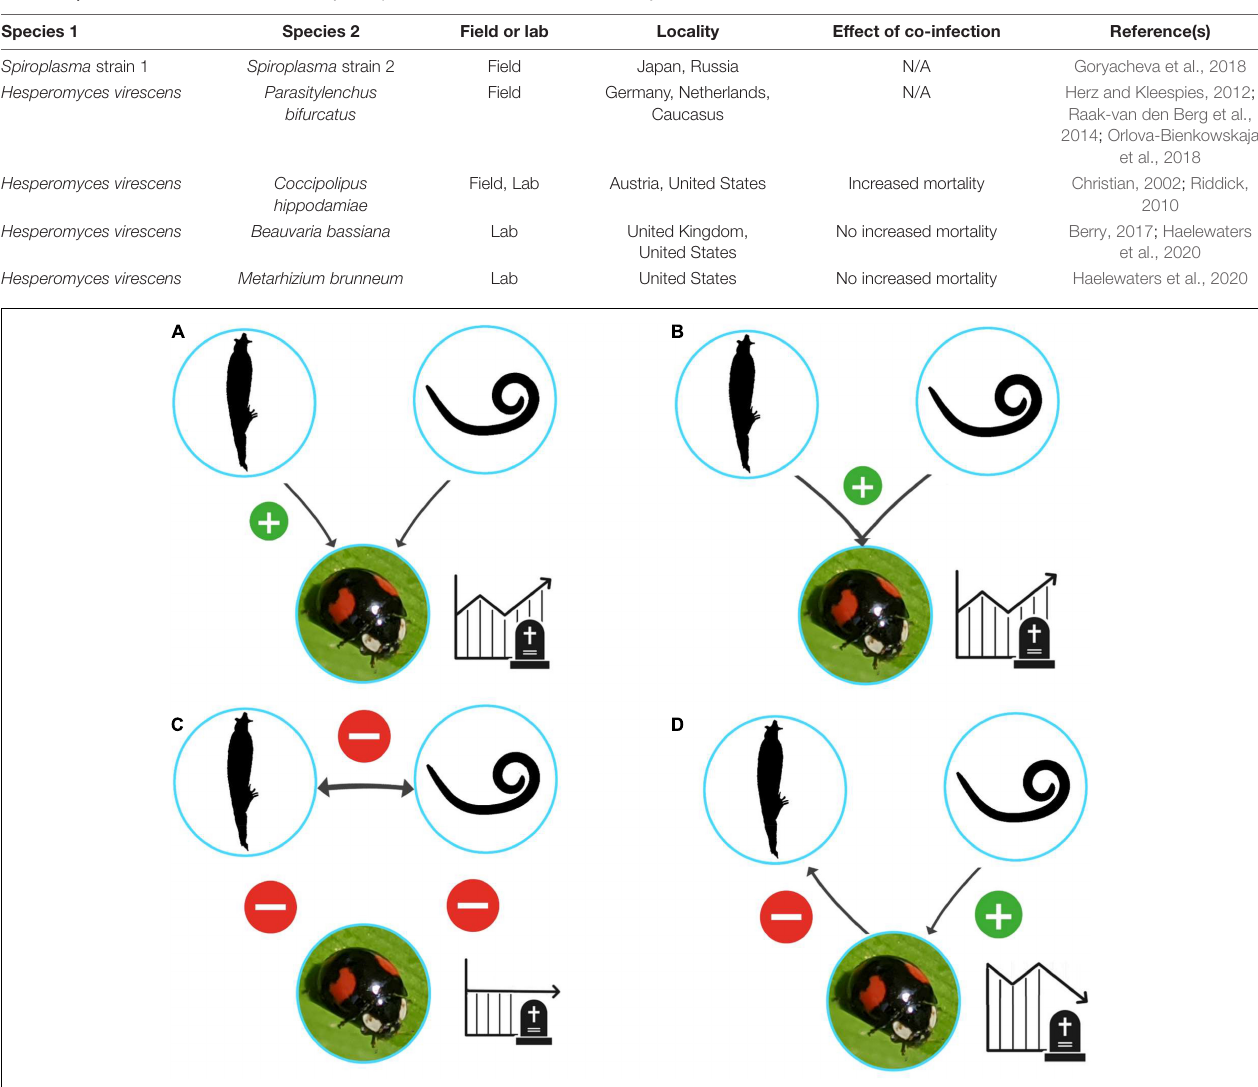
FIGURE 1 | Conceptual overview of potential effects of co-infection by two natural enemies on the fitness of a given host. (A) The co-infection causes no additional decrease in fitness. (B) There is an additive effect of the second enemy, causing a stronger decrease in fitness upon co-infection. (C) The infecting species neutralize each other, causing no increase or decrease in fitness. (D) One natural enemy causes a prophylactic effect in the host, preventing a secondary infection from taking hold, increasing the host’s fitness. Photo: Harmonia axyridis (iNaturalist